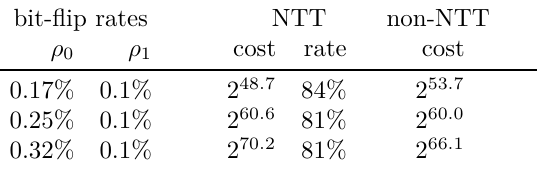
Table 2: Cold boot attacks on New Hope KEM. The column “cost” gives the cost of recovering all 1024 components of the secret in terms of the number of lattice points visited during enumeration ( ≈ 100 CPU cycles each). The column “rate” shows the overall success rate 1 − (1 − p 0 ) 2 for recovering 1024 components of the secret, cf. Section 7. For the columns labelled “non-NTT”, see caption of Table